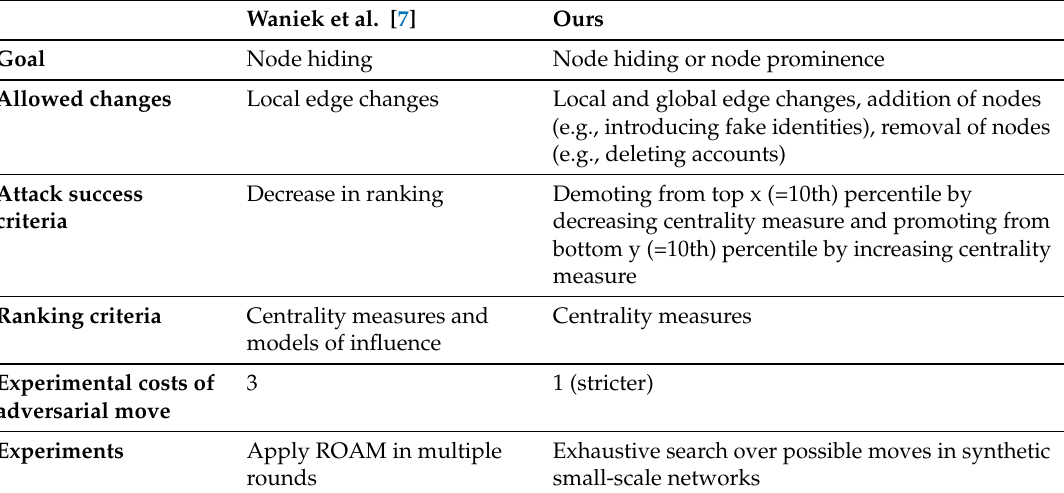
Table 2. Comparison of our approach to Waniek et al.